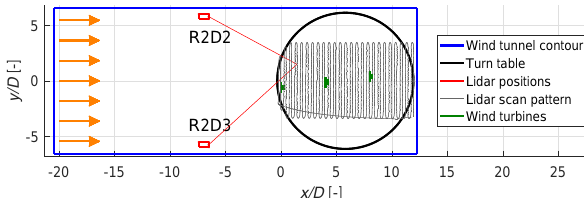
Figure 3. Configuration of the wind tunnel at the Politecnico di Mi- lano with the two scanning lidars and the three model wind turbines installed on the turn table. The axes are normalised with respect to the wind turbine diameter of D = 1 . 1m.